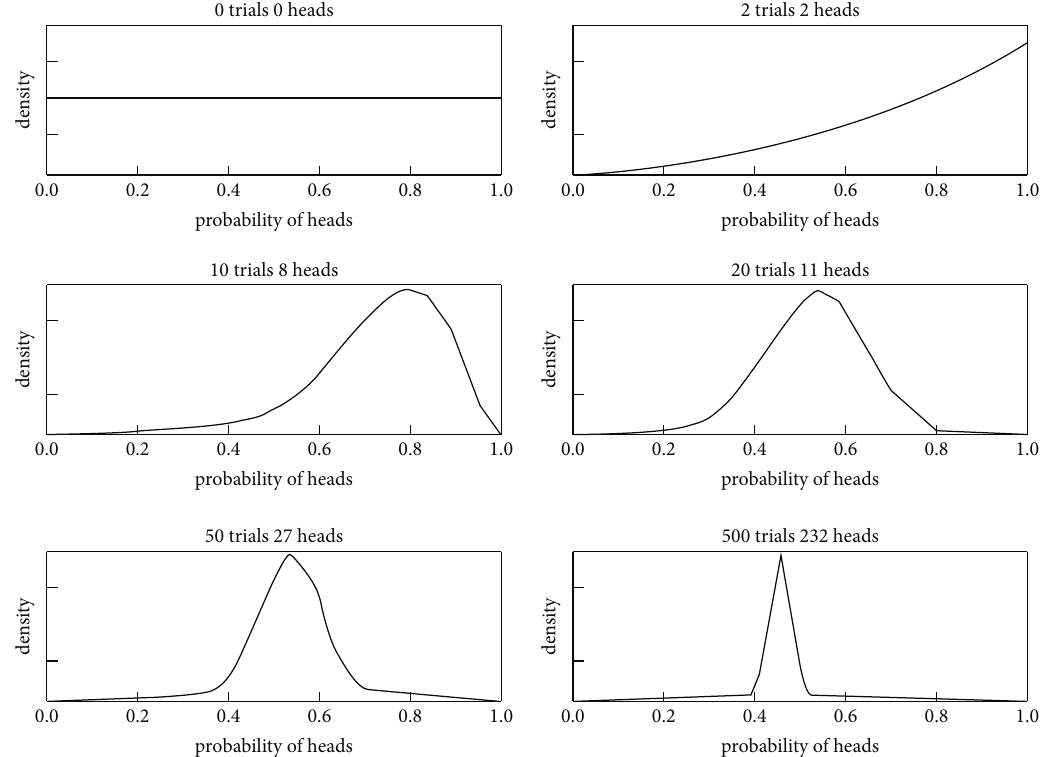
Figure 9: Training probability density of Bayesian model in machine